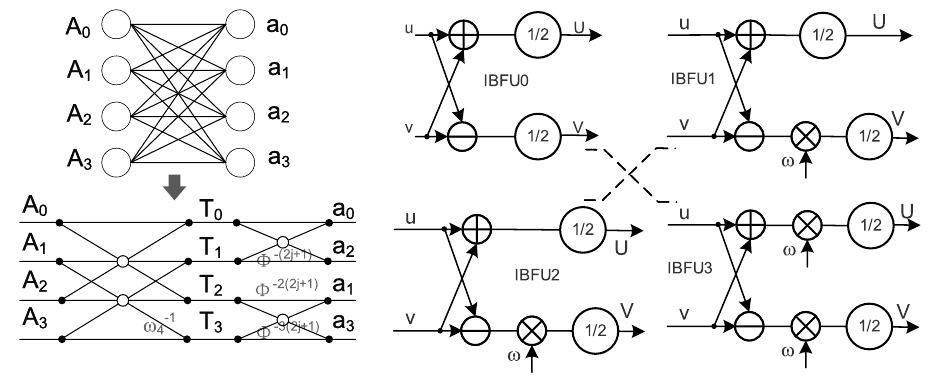
Figure 4: The radix-4 Gentleman-Sande butterfly unit.